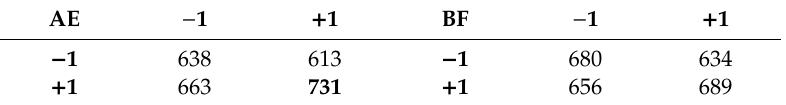
Table 4. Hardness and weight loss in the erosive wear test.